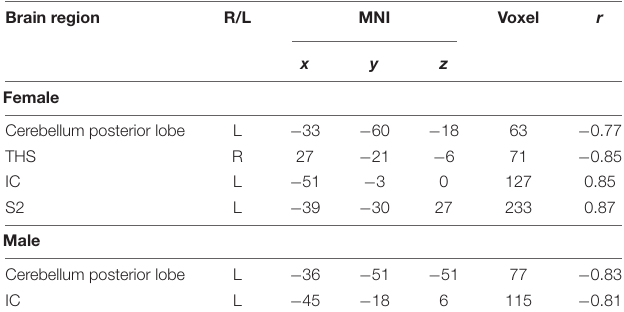
Brain region R/L MNI Voxel